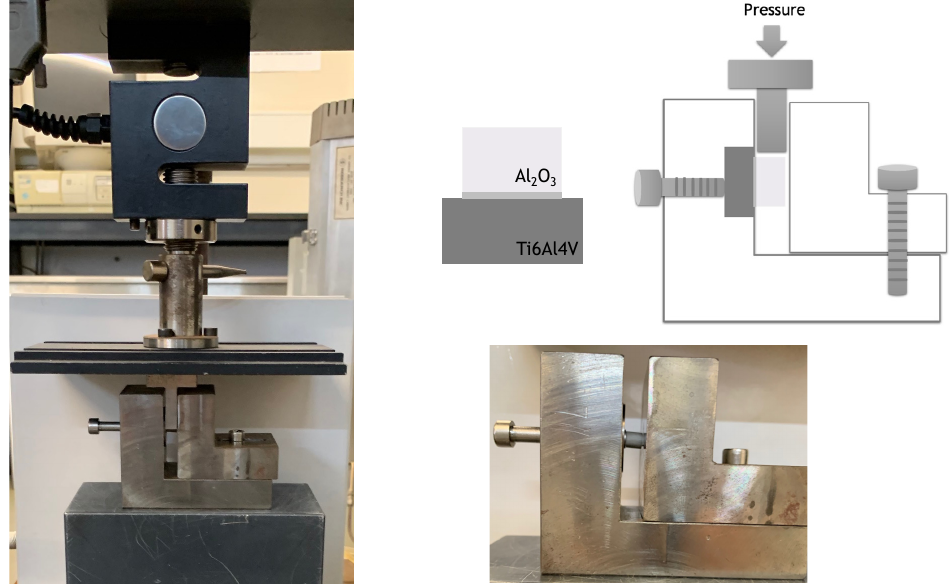
Figure 2. Shear strength test device and respective schematic illustration.